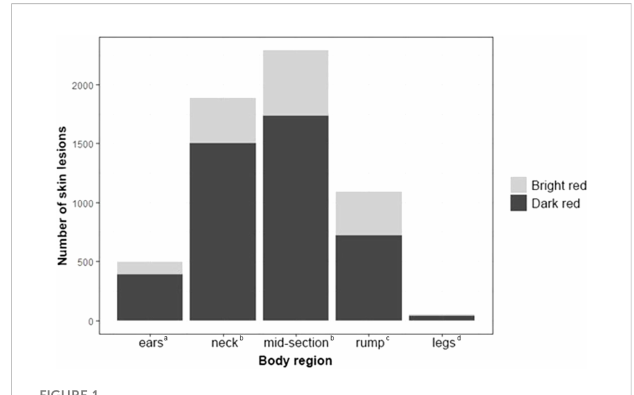
FIGURE 1 Distribution of skin lesions according to the body region and color in fattening pigs in a Colombian slaughterhouse. a,b,c,d Different lower-case superscripts indicate statistically signi fi cant differences ( p ≤ 0.001). The differences were obtained by the Wilcoxon – Mann – Whitney